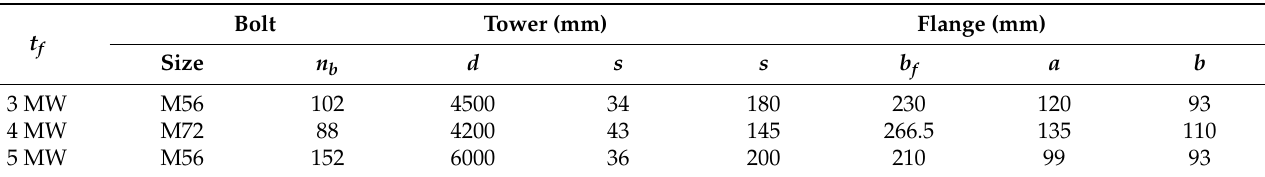
Figure 3. Stress–strain curve [23].